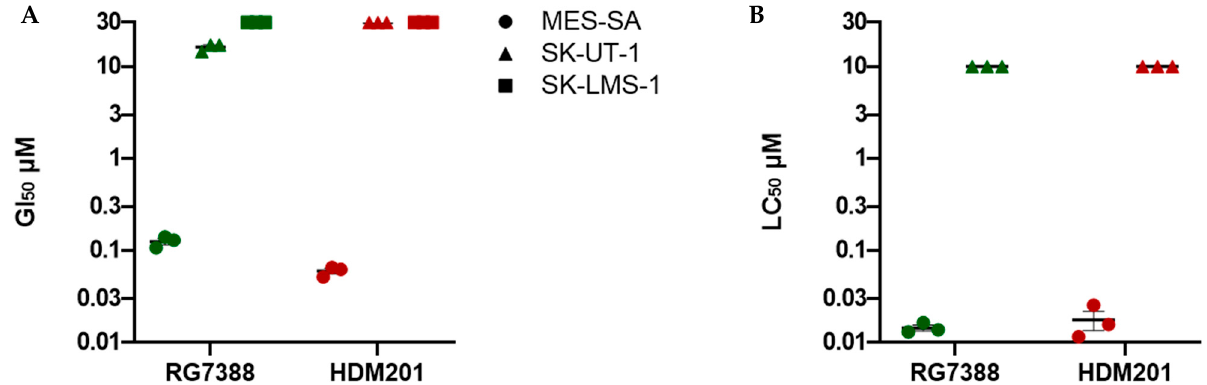
Figure 1. Summary values from growth inhibition and cytotoxicity assays for LMS cell lines treated for 72 h with MDM2 inhibitors, RG7388 and HDM201. ( A ) SRB assay was used to determine GI 50 values. For SK-UT-1 treated with HDM201, and SK-LMS-1 treated with both RG7388 and HDM201, no GI 50 value was reached up to the maximum tested dose of 30 µM; ( B) LC 50 values generated from clonogenic survival assays for MES-SA and SK-UT-1 against RG7388 and HDM201. For SK-UT-1, no LC 50 was reached up to the maximum tested dose of 10 µM. Data represent three independent repeats with mean ± SEM.